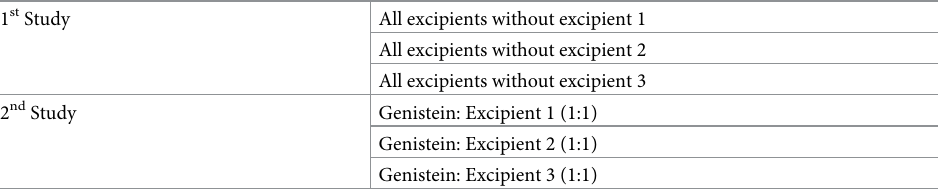
Table 3. Summary of the experiments applied during pre-formulation studies of genistein